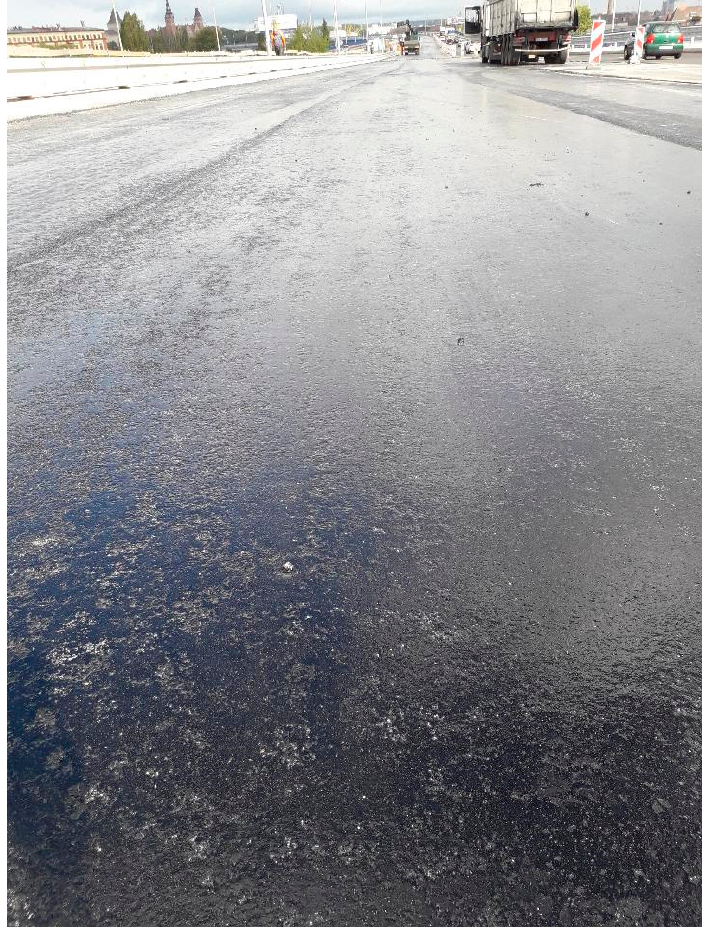
Figure 16. Surface of the SMA-MA layer after compaction.